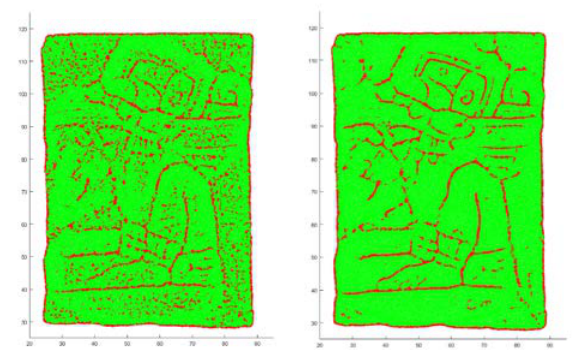
Figure 8. Local minimum maps (original point density);